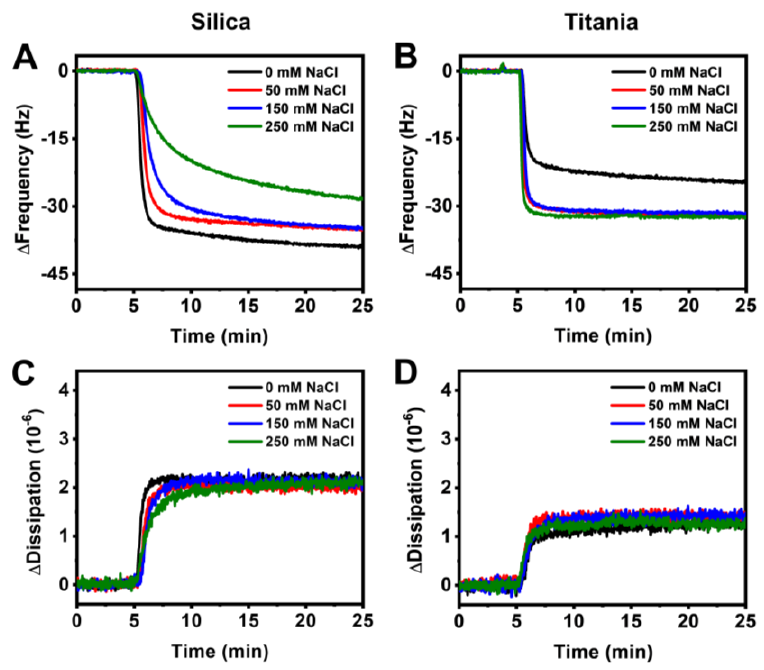
Figure 5. QCM-D frequency shifts for HSA adsorption onto ( A ) silica and ( B ) titania at 0, 50, 150, and 250 mM NaCl. Accompanying dissipation shifts for adsorption onto ( C ) silica and ( D ) titania.